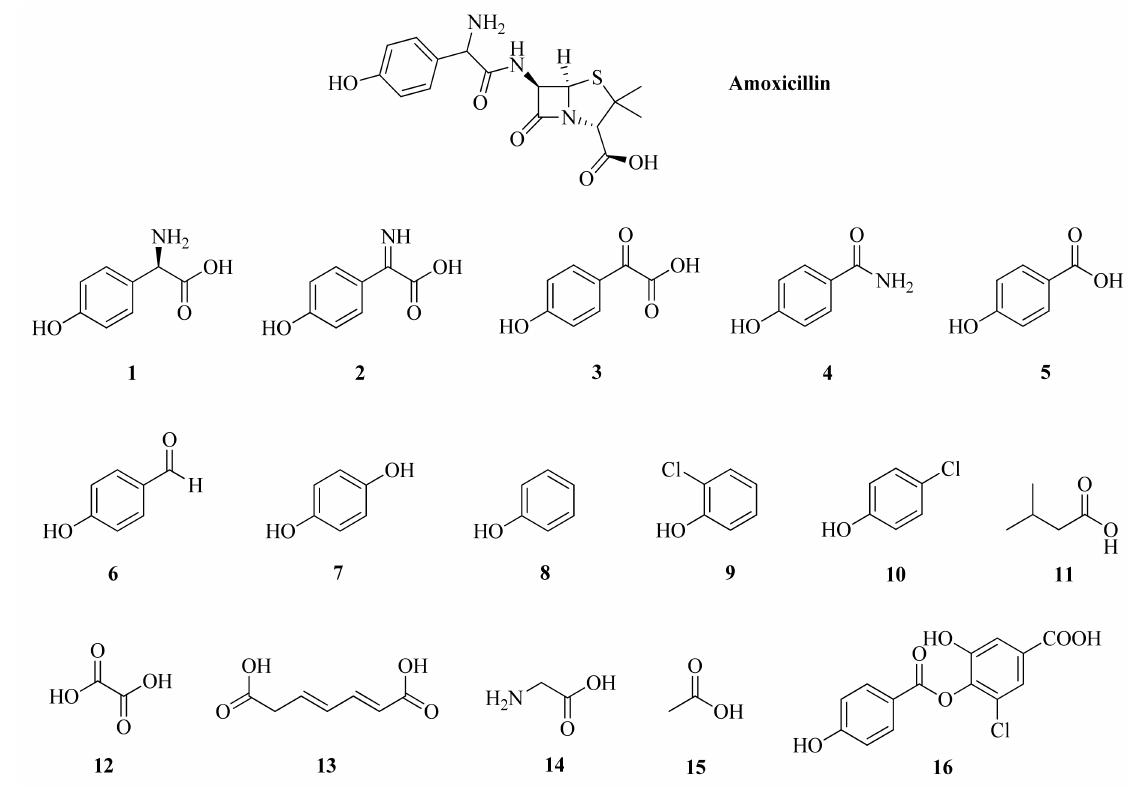
Figure 3. Chemical structures of amoxicillin and its degradation byproducts.